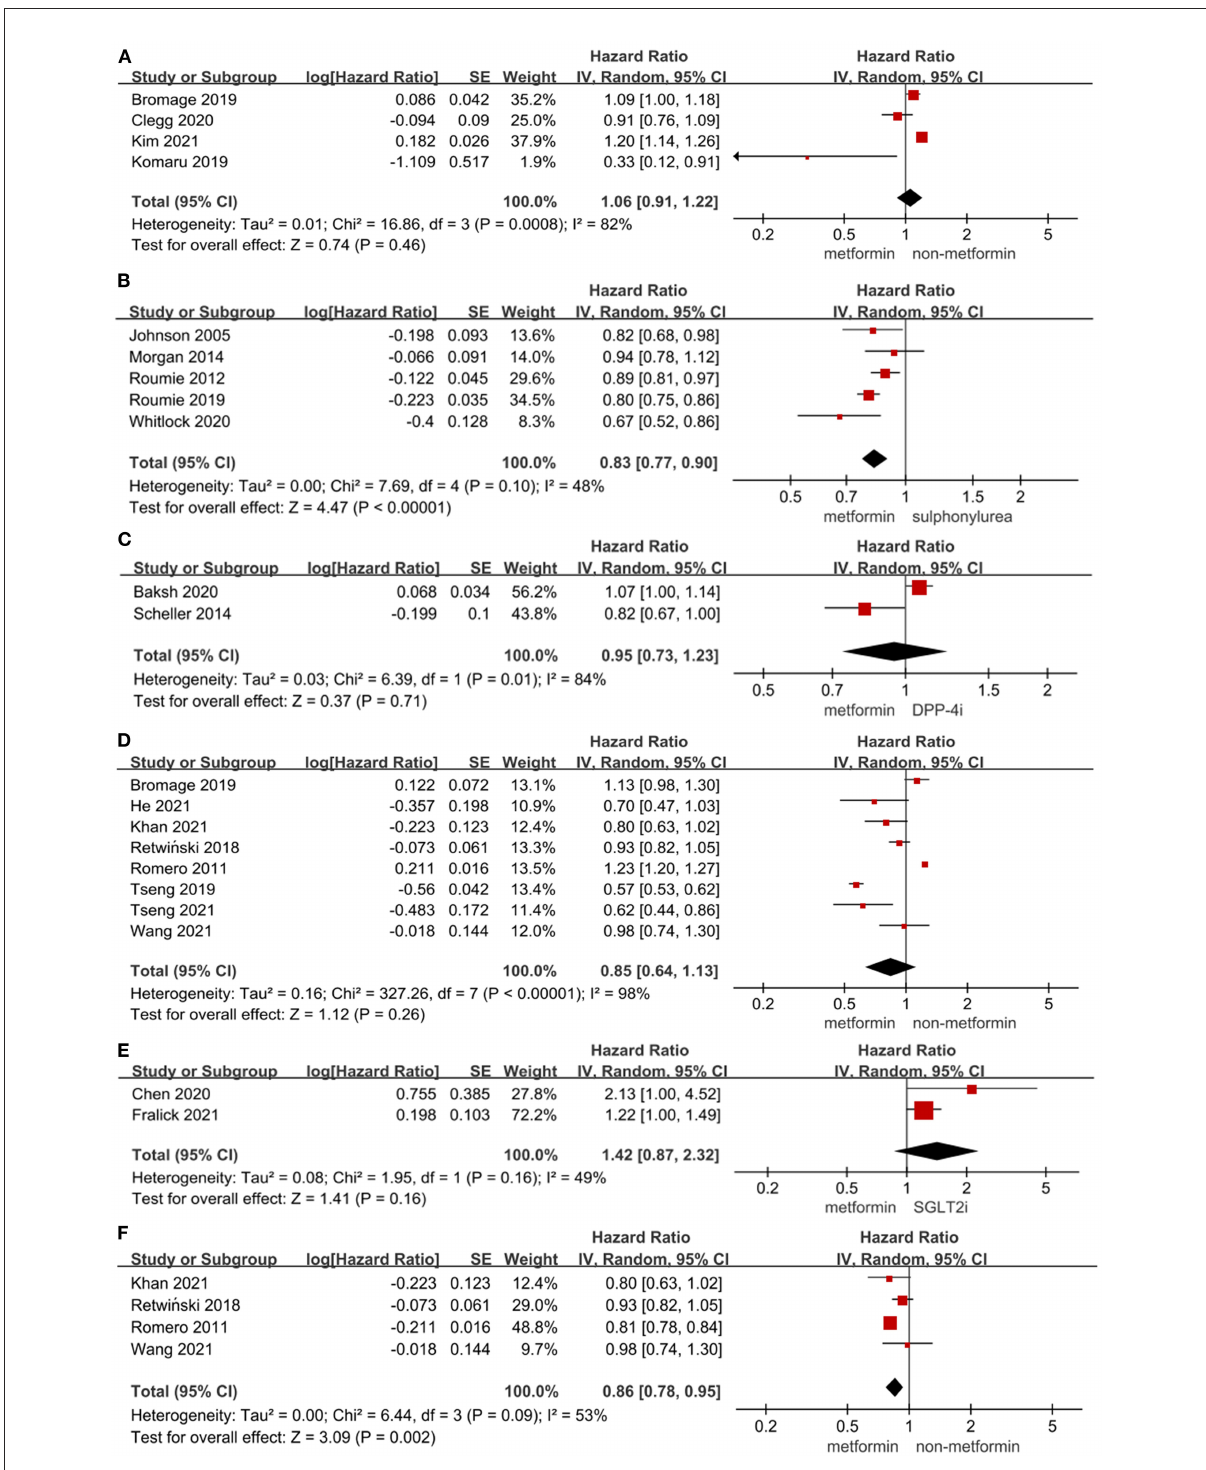
FIGURE1 (A) Forest plot of hazard ratio of MACE among patients with metformin therapy vs non-metformin therapy. (B) Forest plot of hazard ratio of MACE among patients with metformin therapy vs. sulphonylurea therapy. (C) Forest plot of hazard ratio of MACE among patients with metformin therapy vs. DPP-4i therapy. (D) Forest plot of hazard ratio of hospitalization among patients with metformin therapy vs non-metformin therapy. (E) Forest plot of hazard ratio of hospitalization among patients with metformin therapy vs. SGLT2i. (F) Forest plot of hazard ratio of hospitalization among heart failure patients with metformin therapy vs non-metformin therapy. CI, confidence interval; SE, standard error; IV, inverse of the